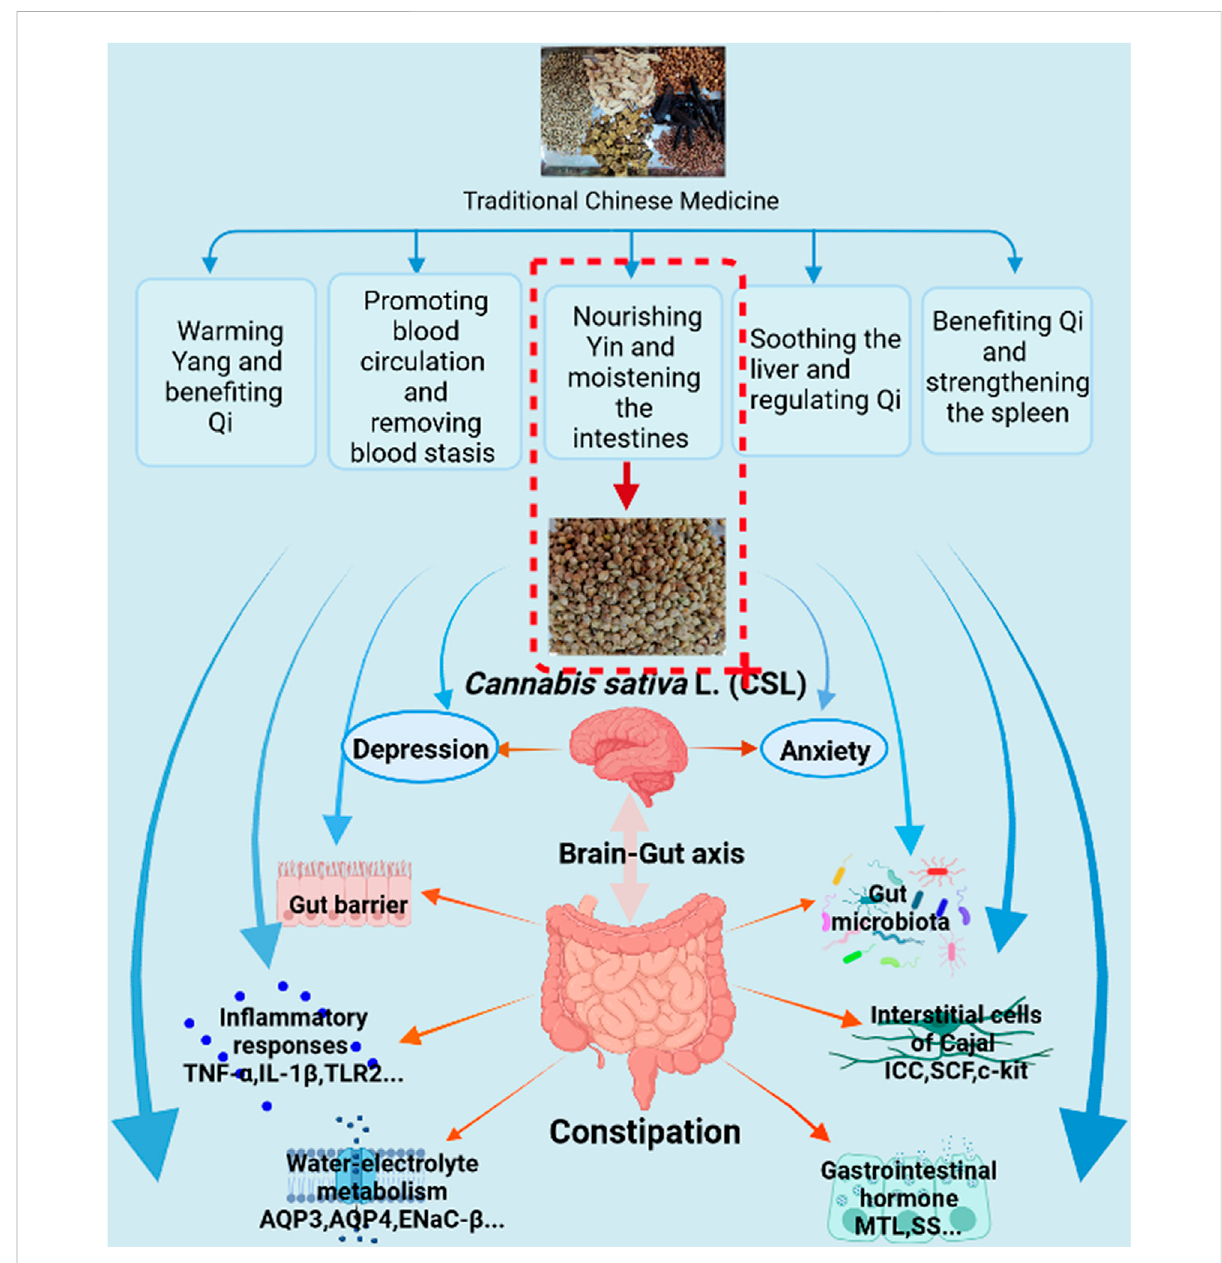
FIGURE 8 Possibleunderlyingmechanismof Cannabissativa L.forconstipationtreatment.The fi gurewasmadeusingBioRender(https://biorender.com).